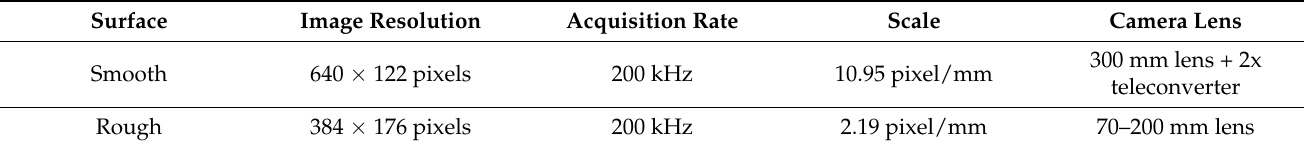
Table 2. Schlieren imaging